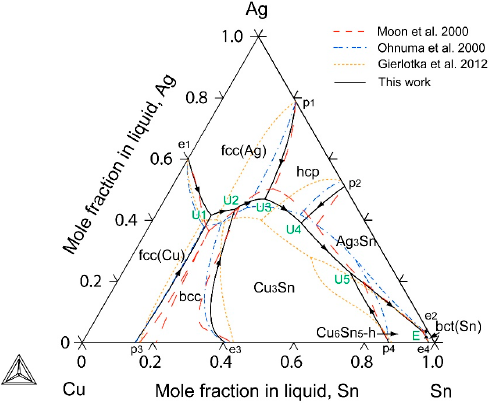
Figure 2. The calculated liquidus projection of the Ag-Cu-Sn ternary system with the calculations from [21,24,28].